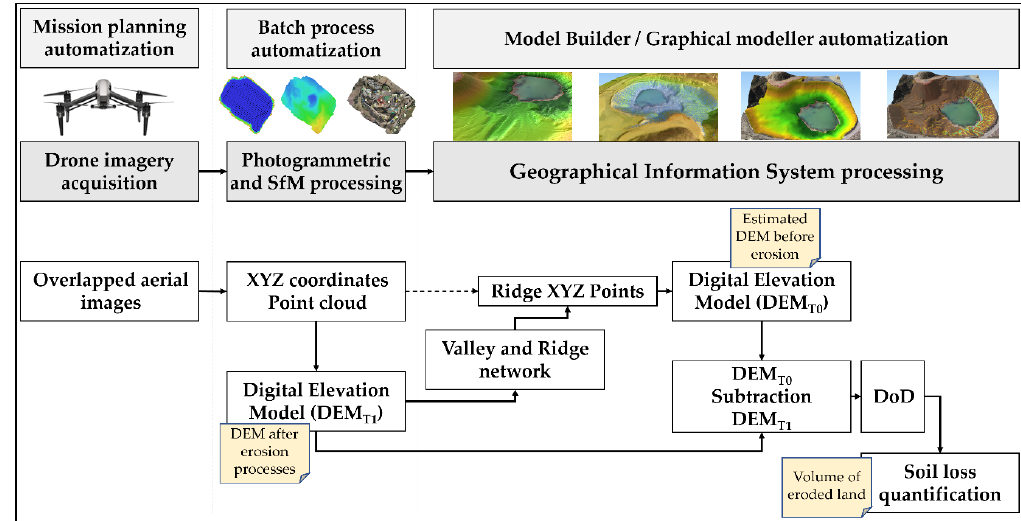
Figure 3. Complete workflow from the data caption to the eroded volume estimation.